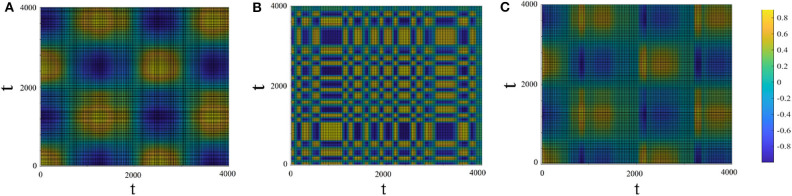
Recurrent plots. The x and y axes are time. The colors in the panels correspond to the values of x1(t1) × x1(t2) (A; driving system), x2(t1) × x2(t2) (B; driven system before connection) and x1(t1) × x2(t2) (C; cross-recurrence between the driving and the driven system after connection). Drive system: μ1 = 2.9, T1 = 1, 000. Driven system: μ2 = 2.1, T2 = 100, r2 = 0.1.